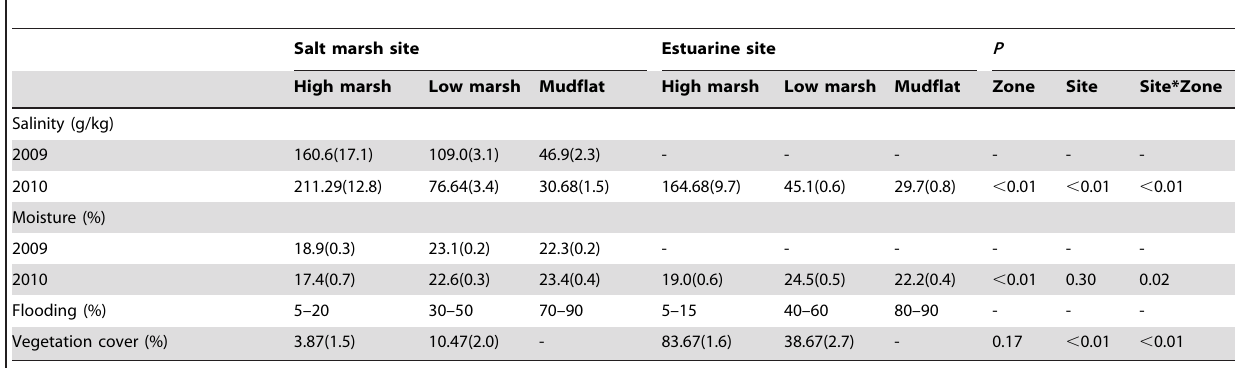
Table 1. Physical stresses and vegetation cover in different zones at the salt marsh and estuarine